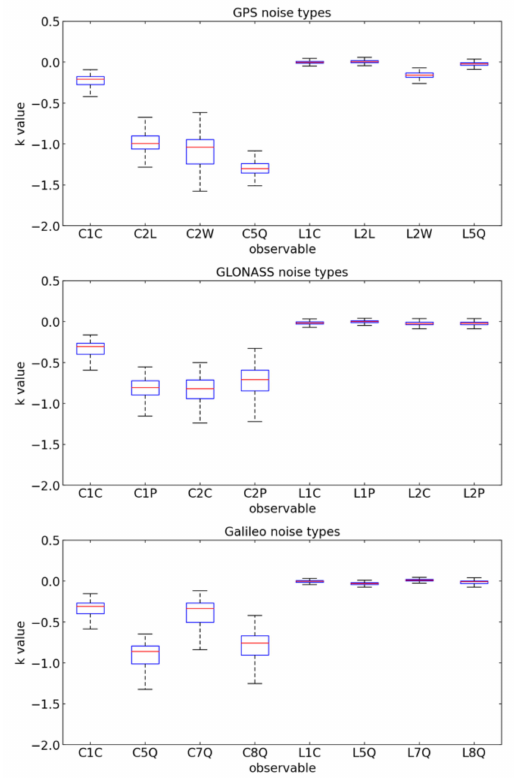
Figure 11. Spectral index for double differences of